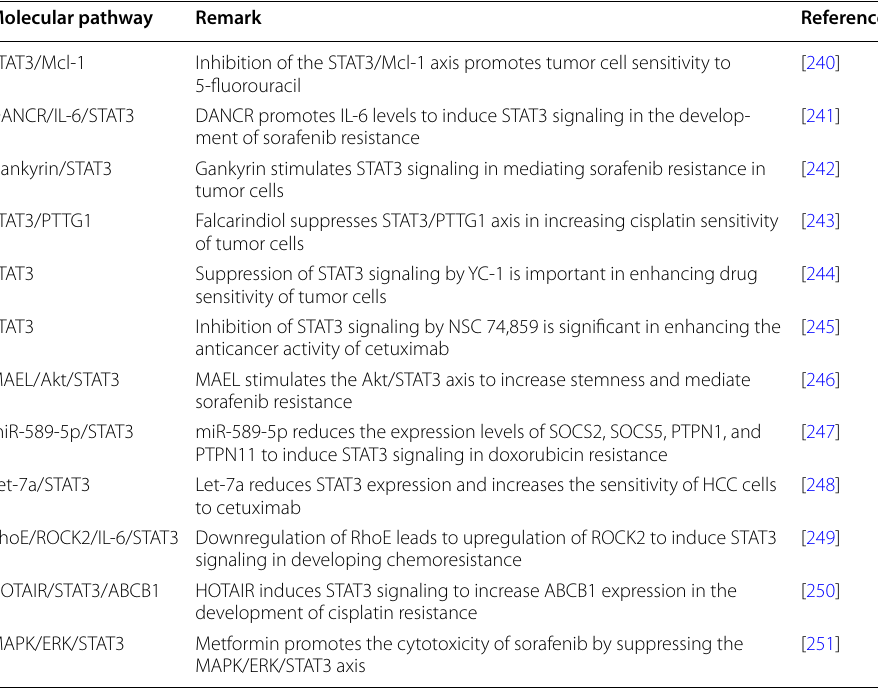
Table 3 The role of STAT3 signaling in developing drug resistance in HCC Molecular